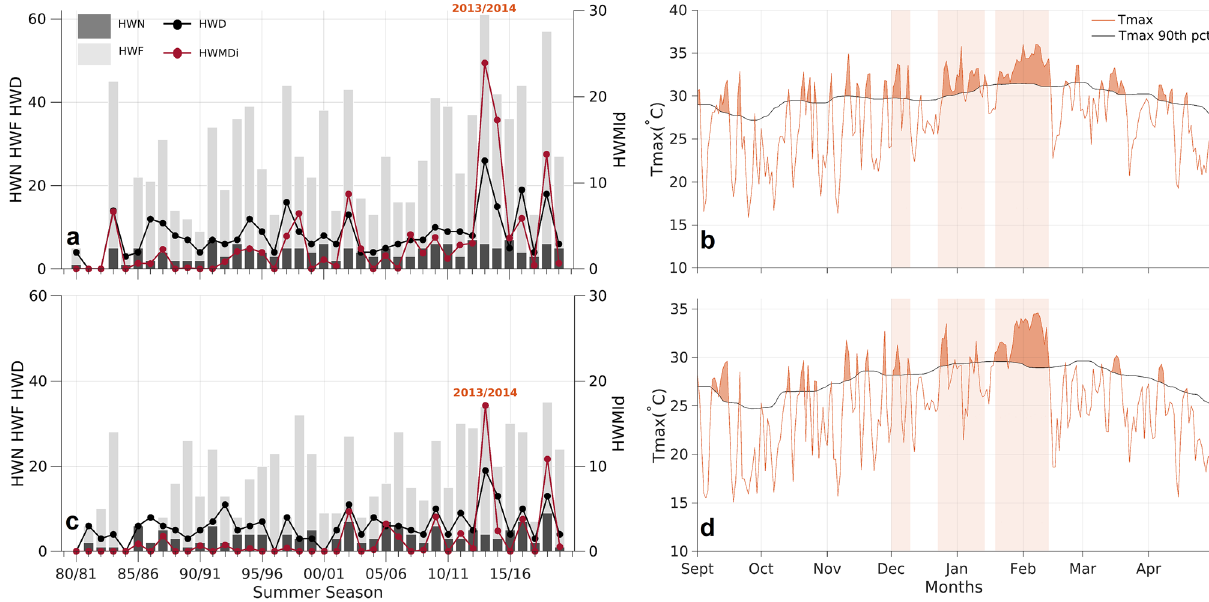
Figure 4. Analysis of the heatwave conditions over the UASP and UACT. Temporal evolution for the summers from 1980 to 2020 of the heatwave parameters: HWN, HWF, HWD and HWMId (see “Data and methods” section) for the UASP ( a ) and UACT ( c ). Daily maximum temperature values (°C, orange line) and the respective 90th calendar day climatological (1981–2010 reference period) percentile (black line) from September 2013 to April 2014 over the UASP ( b ) and UACT ( d ). The results for the UASP were obtained using the averages between the daily maximum temperature values observed at two meteorological stations located within the UASP (see “Data and methods” section). The results for the UACT were also obtained using a maximum temperature record from a single meteorological station located within the UACT (see Data and